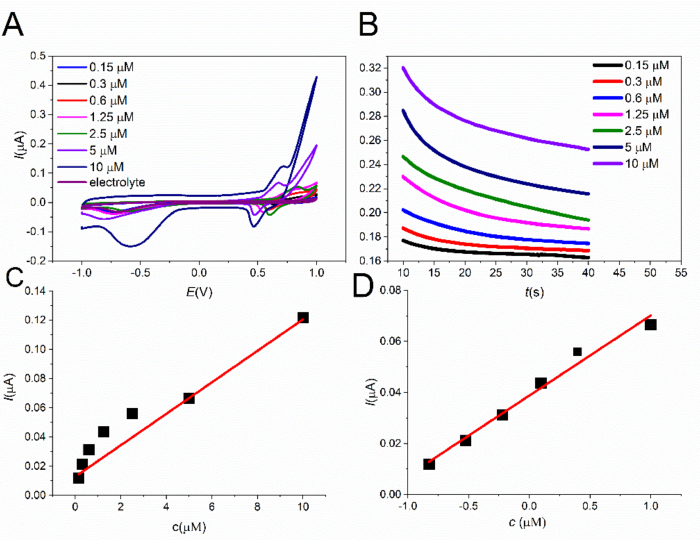
Figure 10. Cyclic voltammograms of different insulin concentrations on SPCE/MWCNT/NiO1.5 ( A ) at a scan rate of 50 mVs − 1 .The dependence of peak current on the insulin concentration, as fitted by a linear function ( C ). I-t responses of SPCE/MWCNT/NiO1.5 to different insulin concentrations for 30 s after applying a potential of 0.7 V ( B ). The dependence of the current response on the insulin concentration, as fitted by a linear function ( D